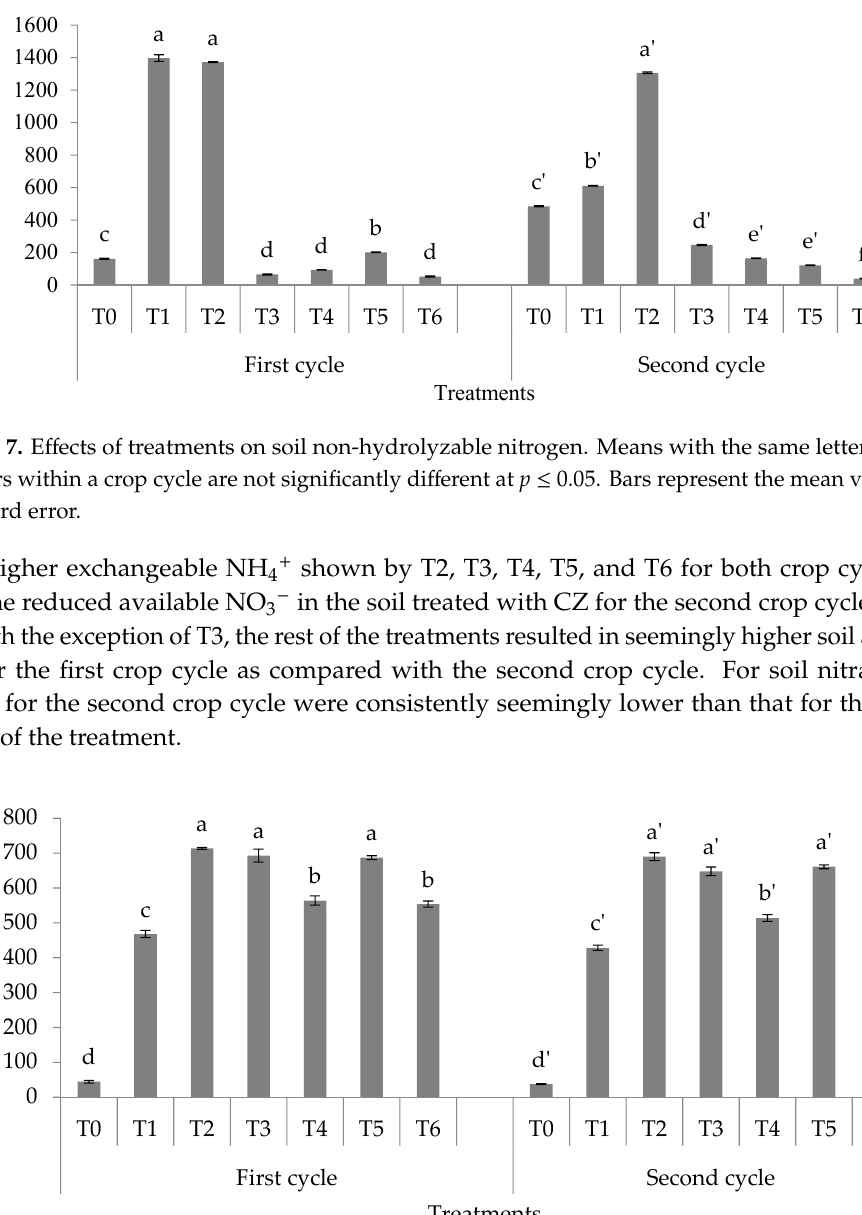
Figure 9. Effects of treatments on soil available nitrate. Means with the same letter above the bars within a crop cycle are not significantly different at p ≤ 0.05. Bars represent the mean values ± standard error . 3.2. Dry Weight, Ear Weight, and Nitrogen Use Efficiency The results show that the dry shoots and ears weighed significantly more for the five treatments containing CZ and composts (T2, T3, T4, T5, and T6) compared with that for T0 and T1, for both crop cycles (Figures 10 and 11). In the first maize crop cycle, there were no significant differences in plant dry weight and ear yield among the treatment combinations (T2–T6). For all the treatments, the results show that dry weight of the maize plants and ear yield for the second cycle were seemingly lower in comparison with the first crop cycle. For the second crop cycle, T4 and T6 resulted in significantly lower ear yield compared with T2, T3, and T5, but the recommended conventional chemical fertilizer treatment (T2) showed comparatively significantly lower yields.